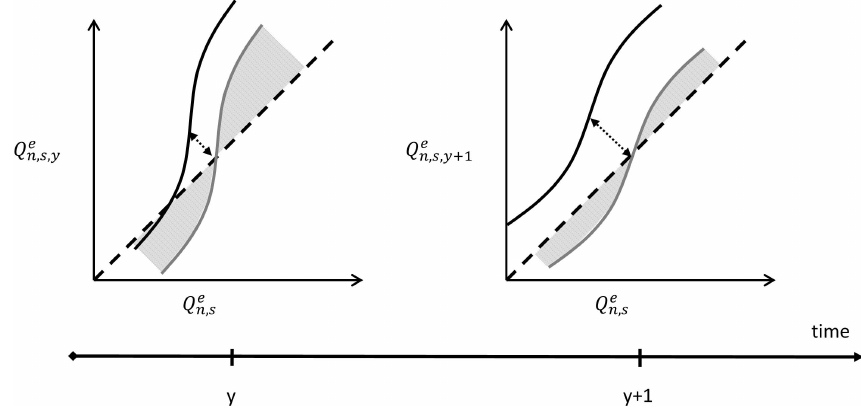
Fig. 2. Decomposition of non-stationarity in the quantile-quantile plots. Full black line indicates quantile-quantile plot. Dot black arrow indicates associated mean bias and the grey full line the unbiased quantile-quantile plot. The remaining variance is indicated by the grey